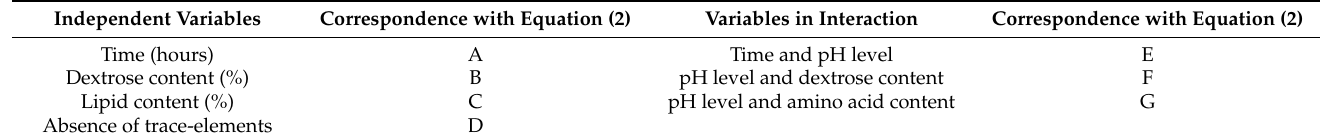
Table 4. Factors used in ANCOVA.